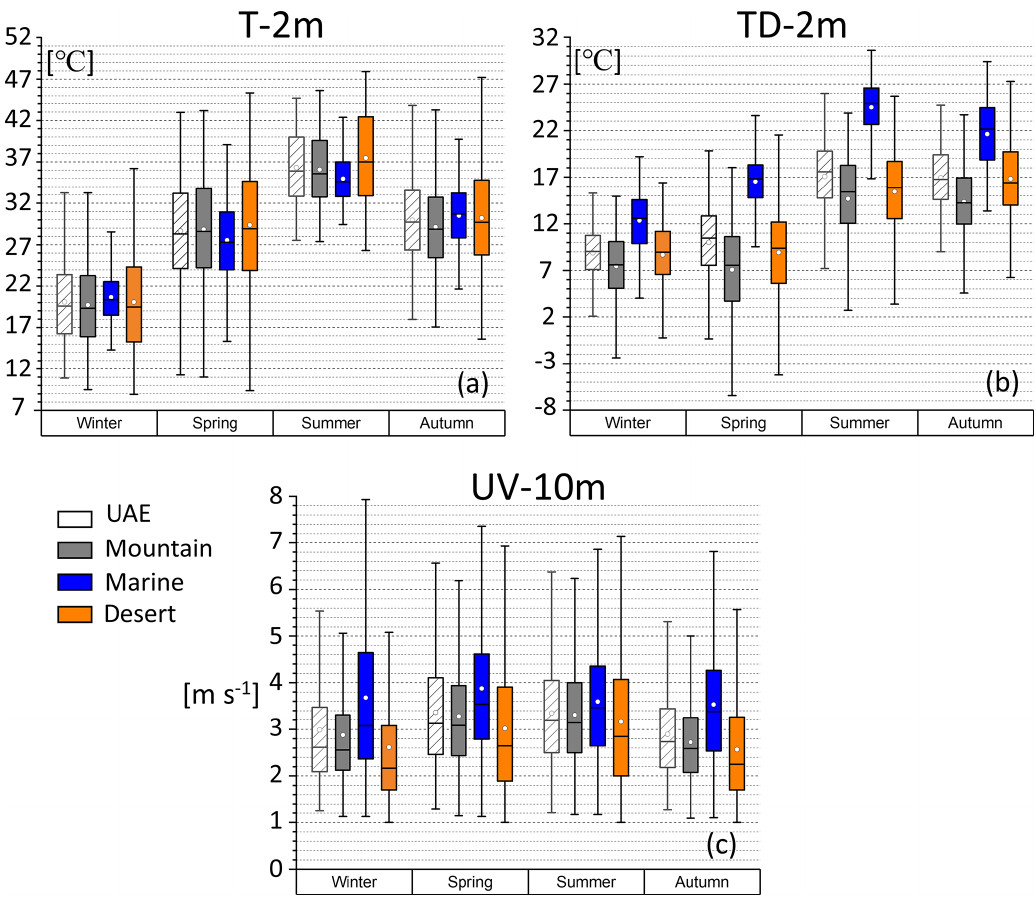
Figure 6. Regional seasonal statistics of mean observations: T 2m (a) , TD 2m (b) , and UV 10m (c) . Box plots show the mean as a center line and median as a dot; box ends are 25% and 75% percentiles, and whiskers are 5% and 95%